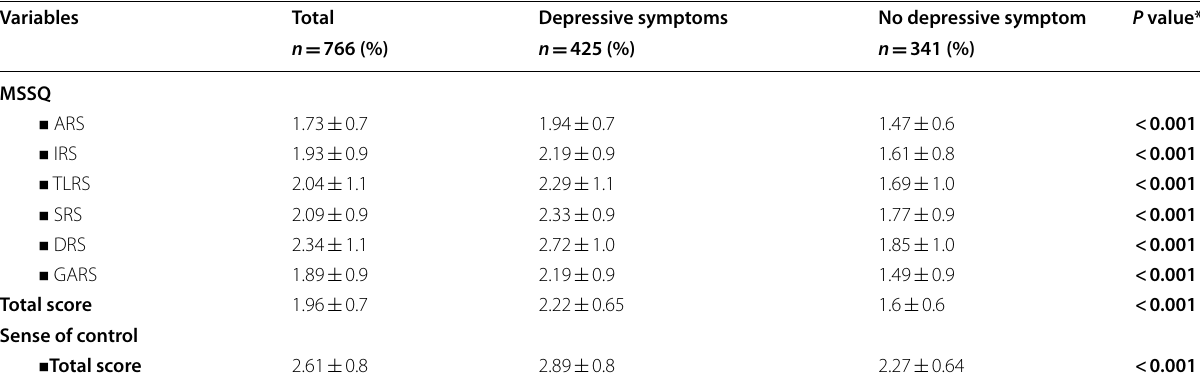
Table 3 Association between stress, sense of control, and depressive symptoms